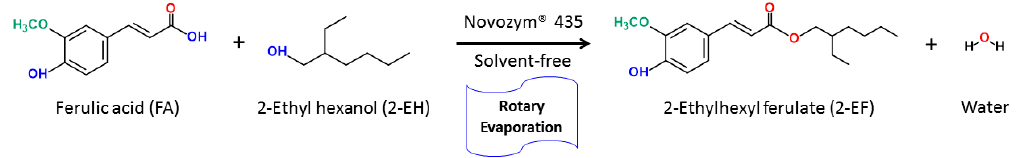
Scheme 1. Enzymatic synthesis of 2-ethylhexyl ferulate.